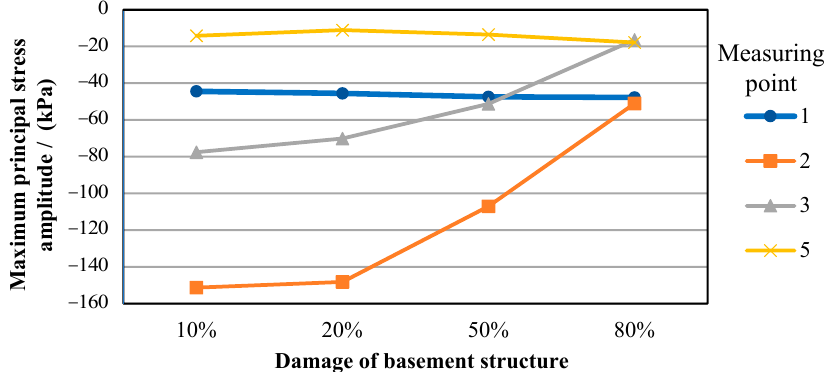
Figure 23. Minimum principal stress increment amplitude diagram of measuring points 1, 2, 3, and 5 under different degrees of damage to the basement structure. Table 18. Minimum principal stress amplitude of measuring points 1, 2, 3, and 5 under different degrees of damage to the basement structure.